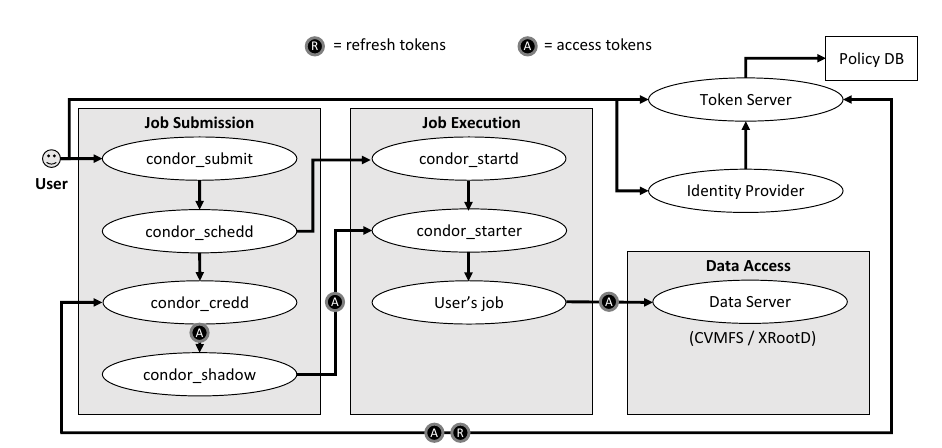
Figure 4. Token flow through HTCondor